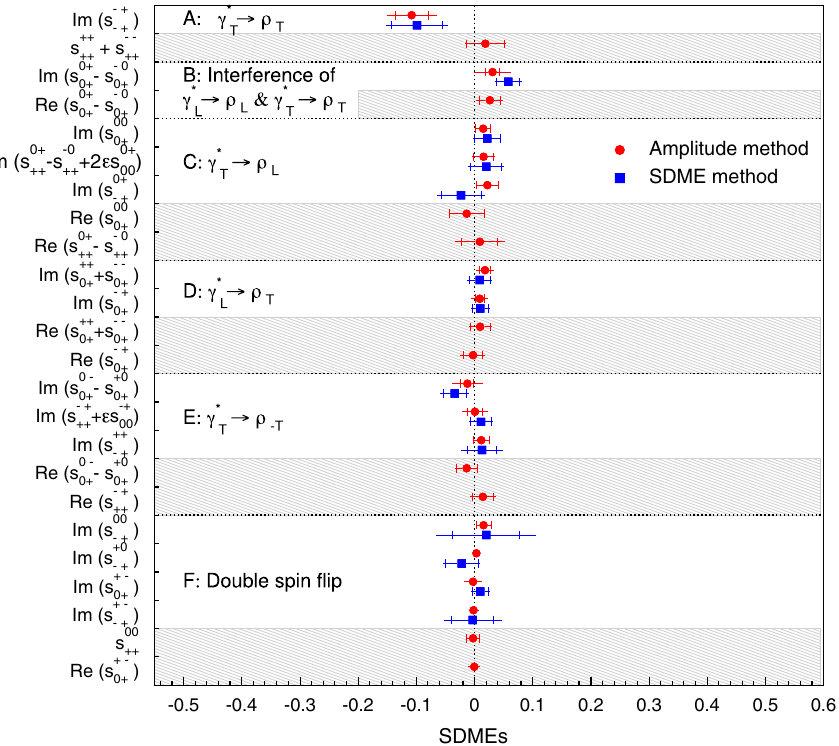
λ V λ (cid:2) V λ required for all SDMEs here. An additional scale uncertainty of 2% Fig. 5 Comparison of the SDMEs s obtained from the amplitude γ λ (cid:2) γ originating from the uncertainty on the beam polarization is present for method ( red circles ) and from the SDME method ( blue squares ). The these SDMEs, but not shown. The inner ( outer ) error bars represent SDMEs are extracted in the entire kinematic region. For the ampli- the statistical (total) uncertainty. An additional scale uncertainty of 8% tude method a 25-parameter fit is used, while the results of the SDME originating from the uncertainty on the target polarization is present, method are taken from the HERMES data in Ref. [29]. The points in but not shown. The SDMEs are ordered according to the SDME classes the shaded area show SDMEs that can be obtained only if the beam is proposed in Refs. longitudinally polarized in addition to the transverse target polarization